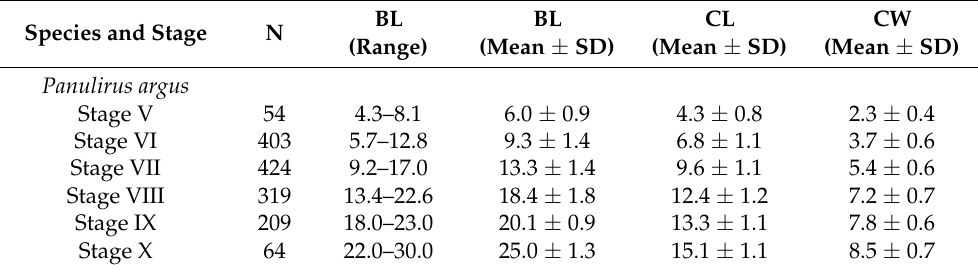
Table 3. Number of mid- and late stage palinurid phyllosomata by species and stage (N), and morphometric measurements: BL (total body length), CL (cephalic length), CW (cephalic width). All measurements in mm. SD: standard